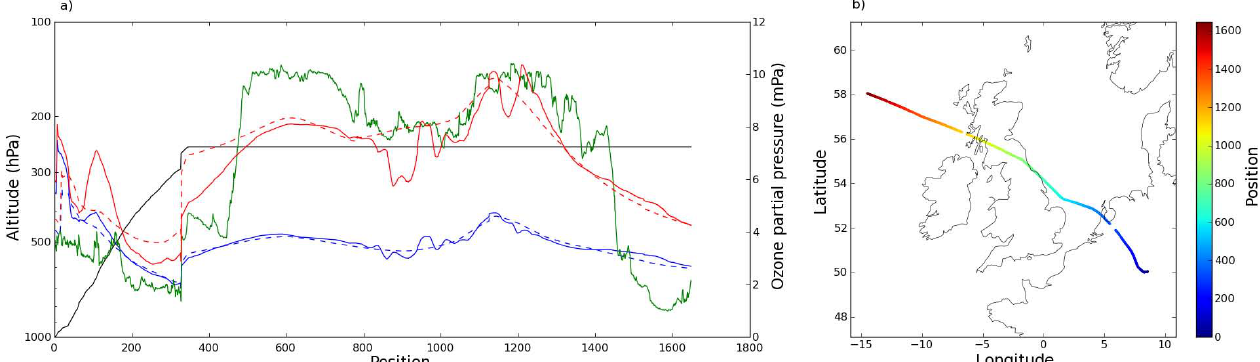
Fig. 9. Left hand side panel: ozone data from MOZAIC (green line), free MOCAGE run (blue lines) and analyses fields (red lines), units of mPa (right hand side y-axis); flight level (black line), units of hPa (left hand side y-axis). Low resolution (2 ◦ ) and righ resolution (0.2 ◦ ) results are marked as dashed lines and solid lines, respectively. Right hand side panel: flight track on 17 july 2009. Position 0 to 1700: starting